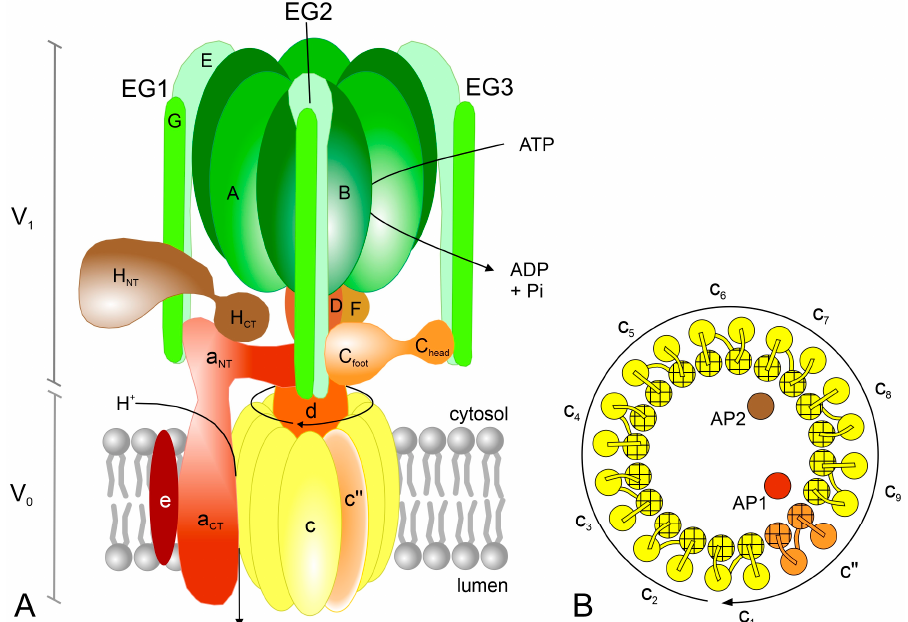
Figure 4. Structure of plant V-ATPase. V-ATPase is a complex of thirteen different subunits organized into two sectors, V 1 and V 0 . ( A ) Overall structure. V 1 sector is composed of subunits A, B, C, D, E, F, G and H. V 0 sector consists of subunits a, c, c ″ , d and e. ( B ) Model of a proteolipid ring composed of nine c subunits and one c ″ subunit; each subunit shows four transmembrane domains. AP1 and AP2 are additional transmembrane helices located in the middle of the